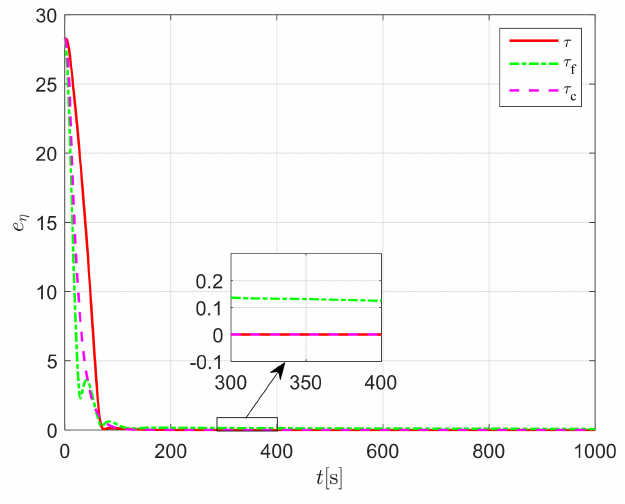
Figure 15. The time response curves of the control performance in Case